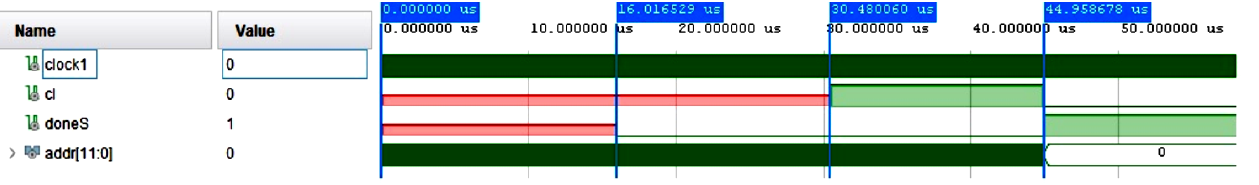
Figure 15. Simulation of the FPGA based CNN implementation.